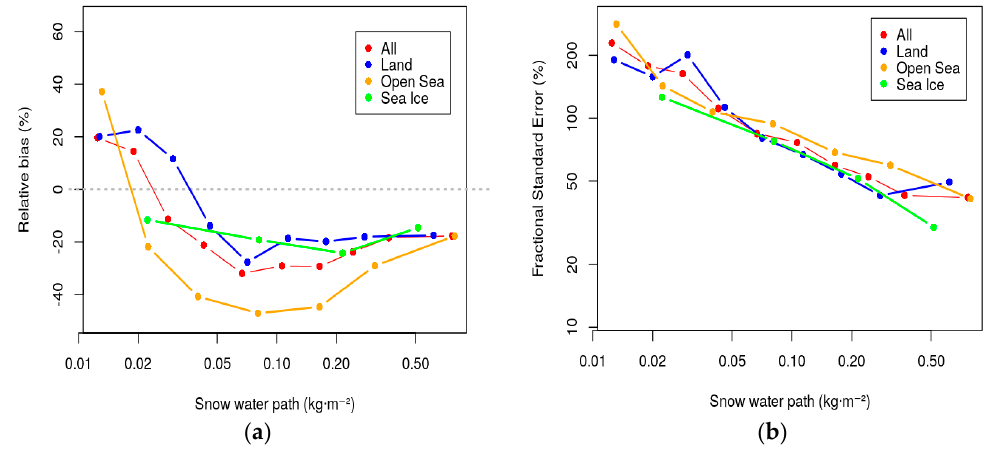
Figure 5. ( a ) Relative bias percentage as a function of SWP and surface type; and ( b ) Fractional Standard Error percentage as a function of SWP and surface type.